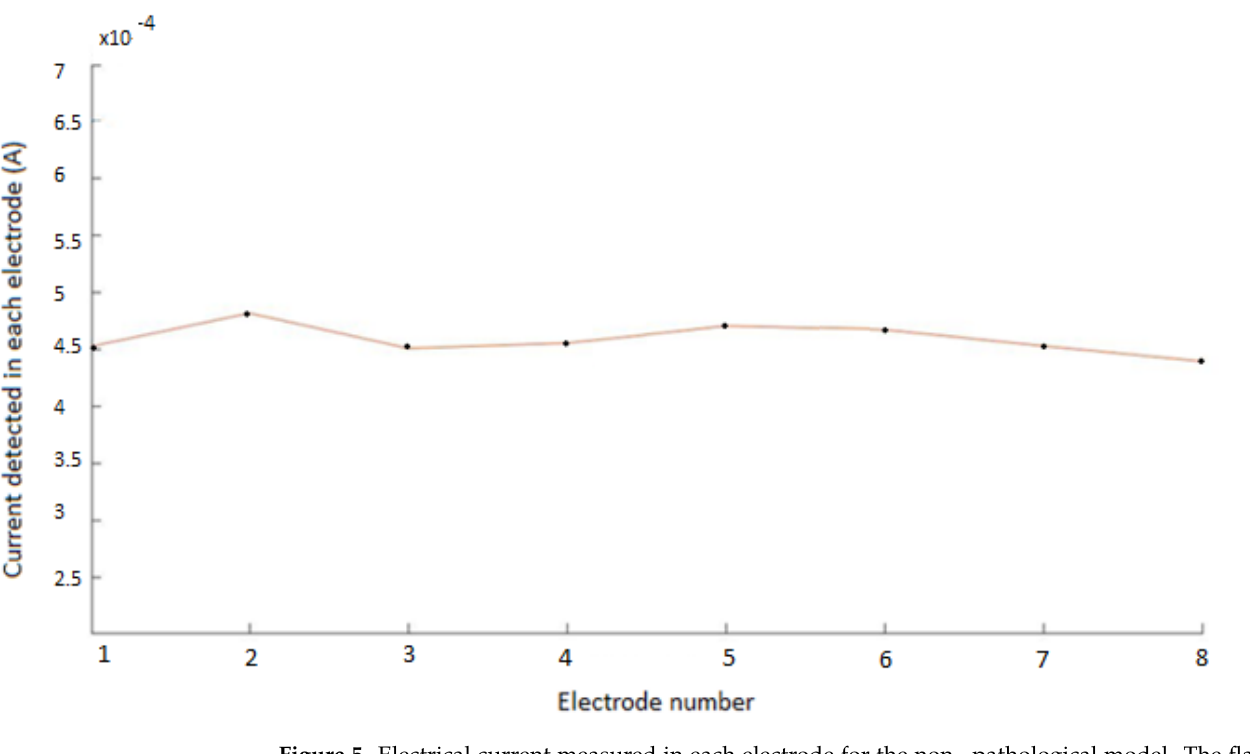
Figure 5. Electrical current measured in each electrode for the non − pathological model. The flat curve corresponds to the symmetry of the modelled system. Small variations ( ± 0.3 A) are due to the precision in the mesh used in COMSOL.